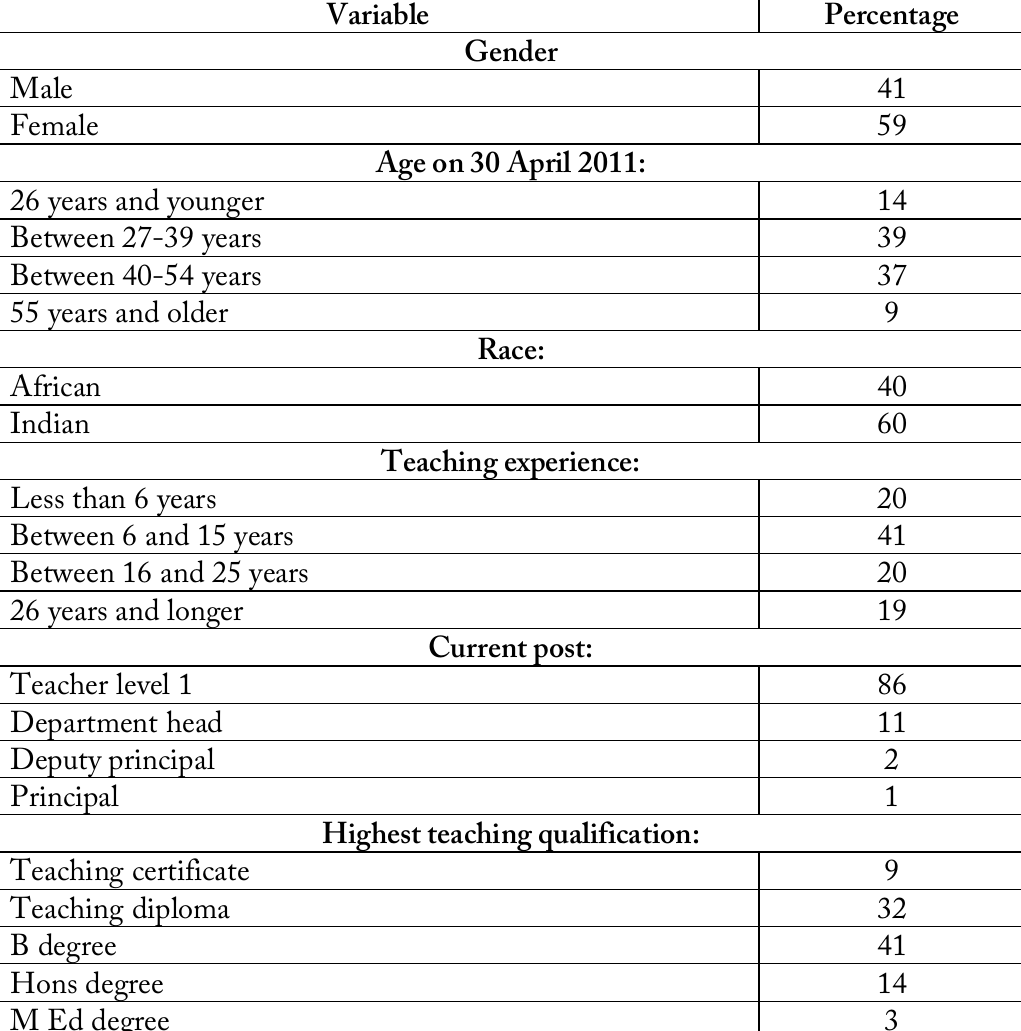
Table 1: Biographical data of the